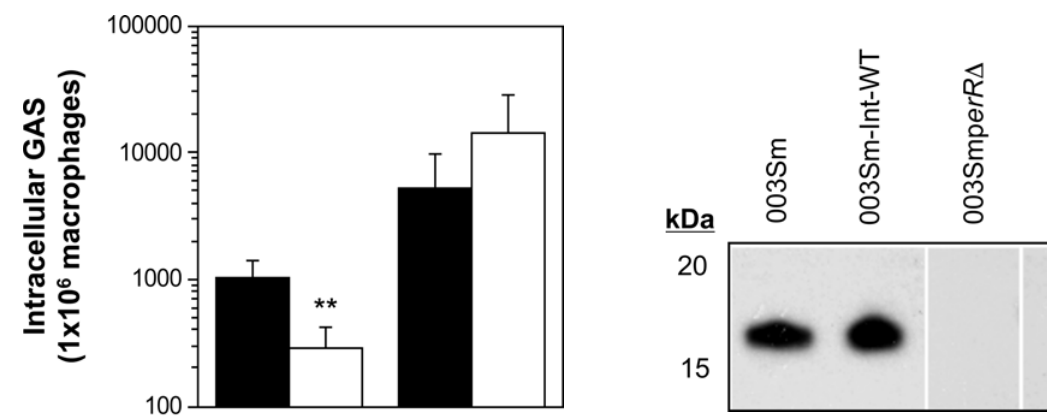
Figure 3. PerR expression in GAS integrant strains 003Sm-Int- perR D and 003Sm-Int-WT and the perR deletion mutant strain 003Sm perR D as determined by immunoblotting. Cell lysates of the three strains, as well as of parent strain 003Sm, were fractionated by SDS-PAGE and immunoblotted with PerR-specific rabbit antiserum. Note the loss of PerR in both 003Sm perR D and 003Sm-Int- perR D in contrast to wild-type PerR expression levels in 003Sm-Int-WT.